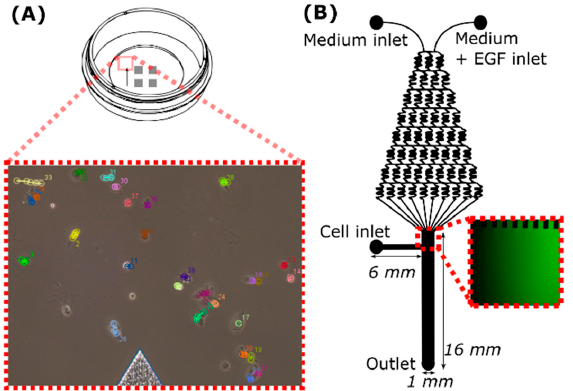
Figure 3. Schematic view of a µ-dish ( A ) with the inset of tracked cells and microfluidic device ( B ) with fluorescence image (inset) of the main channel where the gradient flow of the fluorescein could be seen.